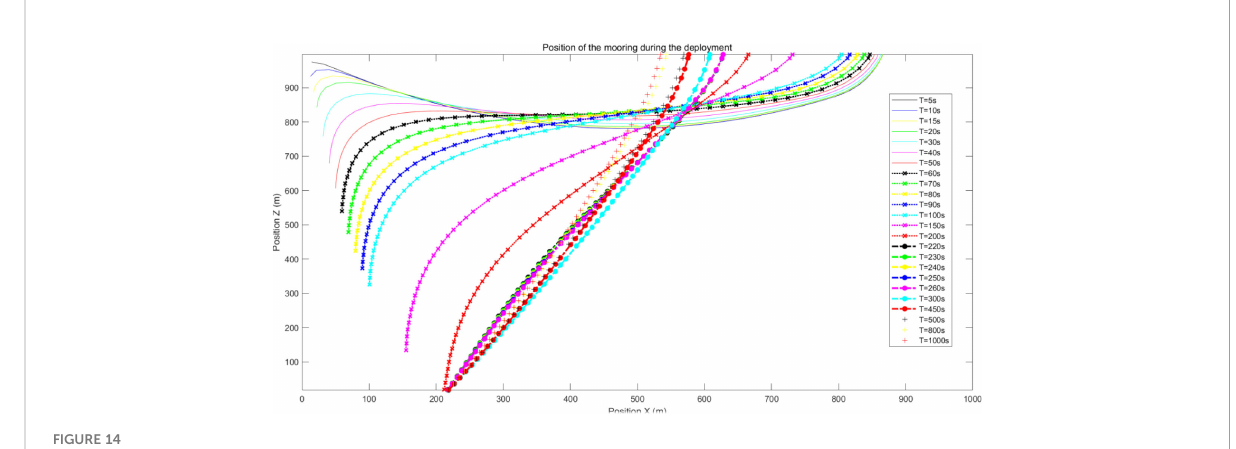
FIGURE 14 Change in the shape of the mooring line during